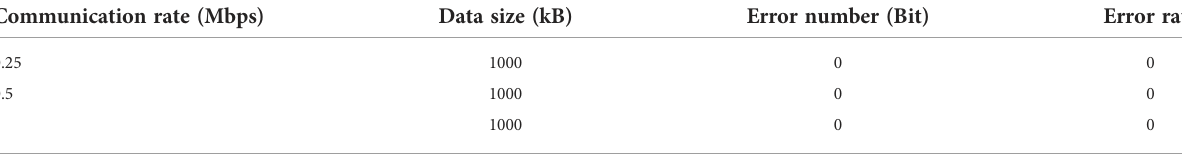
TABLE 2 Statistical table of communication bit error rates at a distance of 3.5